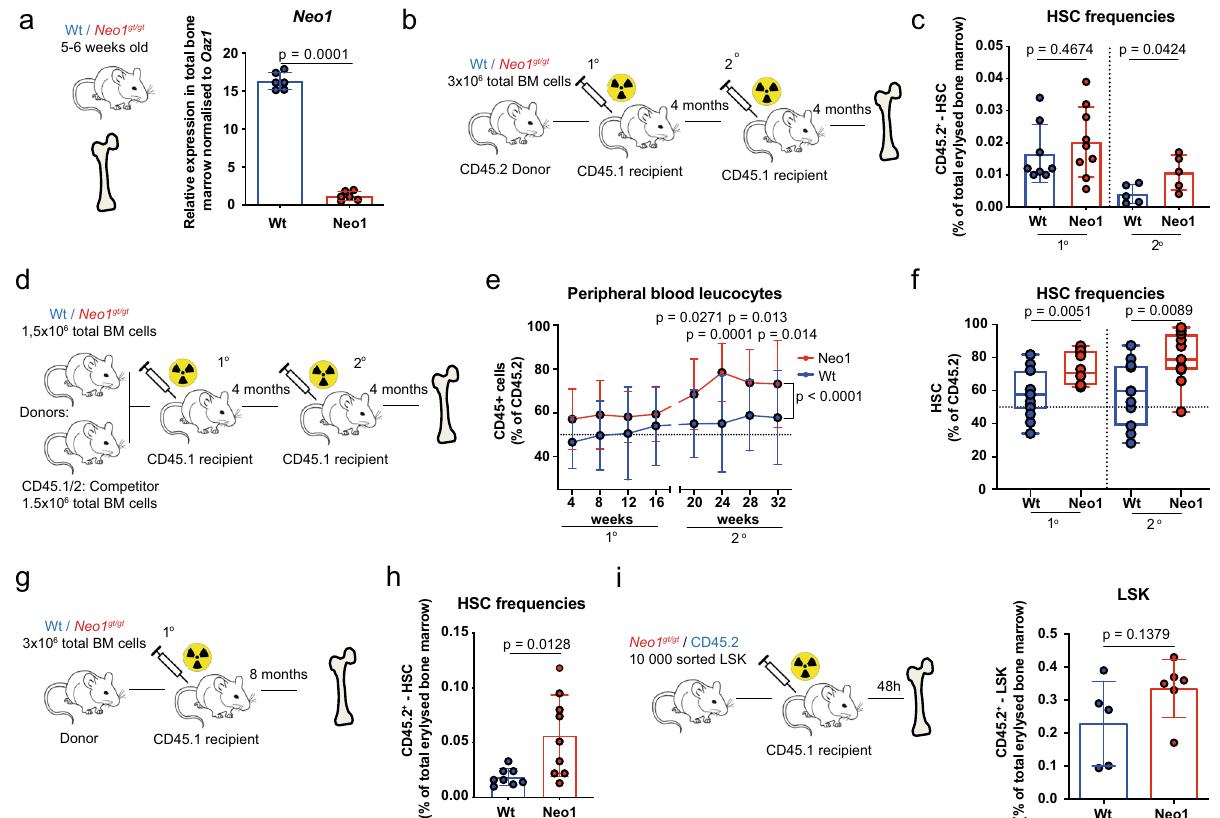
Fig. 2 Mutant Neo1 causes an initial HSC expansion. a Relative expression of Neo1 in the total bone marrow of Wt and Neo1 gt/gt mice; n = 6, three independent experiments. b Work fl ow: generation of full chimeras. c Absolute frequencies of bone marrow CD45.2 + HSCs in full Wt and Neo1 gt/gt chimeras 4 months after fi rst and second transplantation; n = 5 (2nd Tx) – 8 (Ctrl 1st Tx) and 9 (Neo1 1st TX), two independent experiments. d Work fl ow: competitive transplantations. e Peripheral blood CD45.2 + chimerism during 1° and 2° competitive transplantations of Wt and Neo1 gt/gt bone marrow; n = 13 – 17 (for exact n /timepoint please see Source data fi le), three independent experiments, Analysis with two-way ANOVA, multiple comparison with LSD Fisher ’ s test. f CD45.2 + chimerism of HSCs at endpoints of 1° and 2° competitive transplantations of Wt and Neo1 gt//gt bone marrow; n = 11 (2nd TX), 12 (Ctrl 1st Tx), 14(Neo1 1st TX), three independent experiments. Whiskers are min – max, box is 25 – 75th percentile and line is mean. g Work fl ow: full chimeras studied in ( h ). h Absolute frequencies of bone marrow CD45.2 + HSCs in full Wt and Neo1 gt//gt chimeras after 8 months; n = 8 (Ctrl) – 9 (Neo1), three independent experiments. i Work fl ow: Homing assay in ( j ). j Absolute frequencies of CD45.2 + bone marrow LSK cells 48 h after transplantation of 10,000 sorted Wt and Neo1 gt//gt LSK; n = 5 (Ctrl) – 6 (Neo1). For all panels, ±SD is shown. n indicates biological replicates. P value was determined by two- tailed t test unless stated otherwise. Source data are provided as a Source Data fi